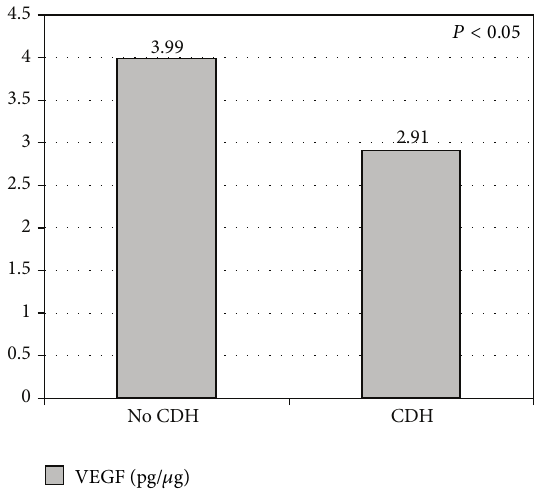
Figure 5: Vascular endothelial growth factor VEGF in fetuses with and without congenital diaphragmatic hernia. Values are expressed as mean in pg/ 𝜇 g.